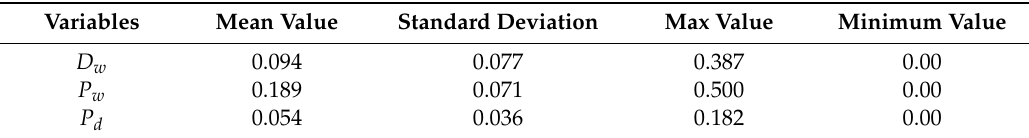
Table 5. Statistical features of the